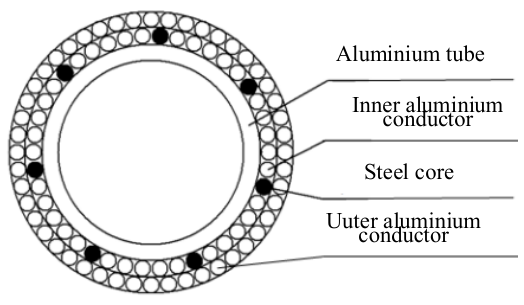
Figure 12. Cross sections diagram of DEC.